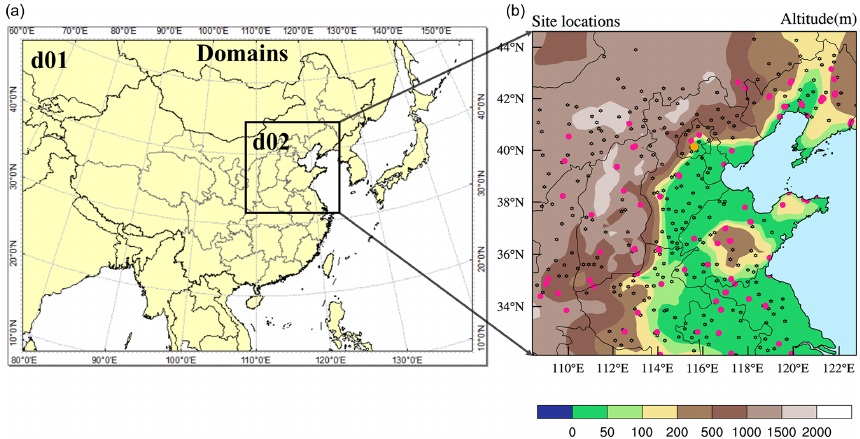
Figure 1. Domains of WRF-Chem used in this study (a) , and the locations of one HONO observation site (orange dot in urban Beijing), 95 environmental monitoring (PM 2 . 5 , NO 2 and O 3 ) sites (dark pink dots), and 284 meteorological observation sites (black dots) in domain 2 (b)